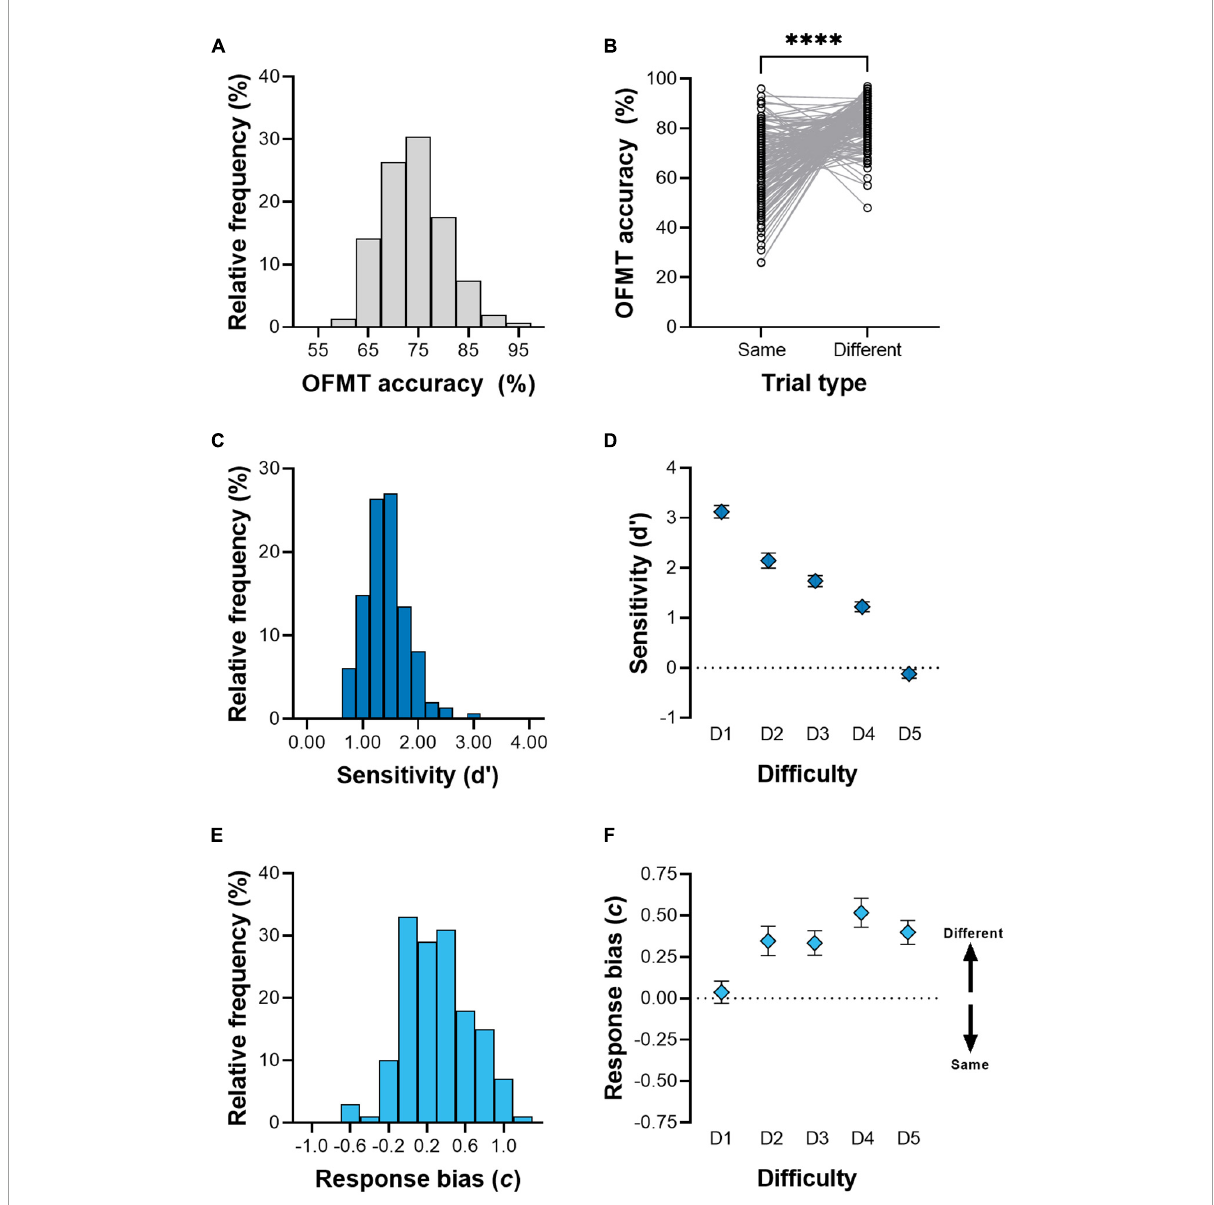
FIGURE2 Accuracy, sensitivity, and response bias in the OFMT. (A) Distribution of overall accuracy in the OFMT across trial types and difficulties. (B) Accuracy difference between trial types. (C) Distribution of d (cid:48) values. (D) Average sensitivity (d (cid:48) ) (95% C.I.) as a function of difficulty. (E) Distribution of response biases. (F) Average (95% C.I.) response bias as a function of difficulty. ∗∗∗∗ P = 2.6 × 10 − 19